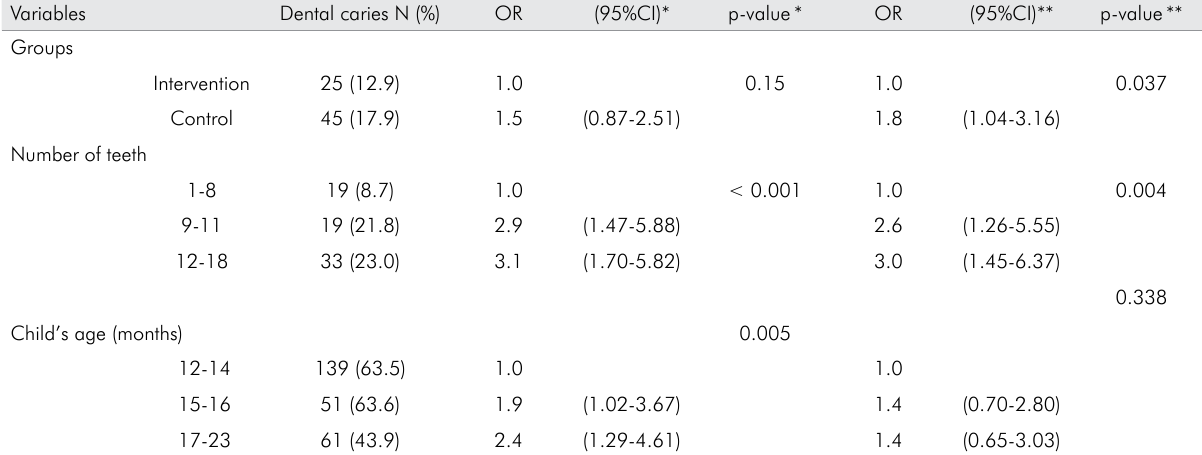
OR: odds ratio; CI: confidence interval. *Unadjusted crude univariate analysis. **Adjusted for number of teeth and child’s